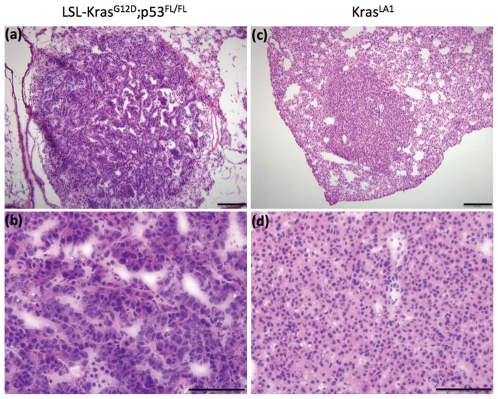
Hematoxylin and eosin staining showing characteristics of high-grade lung cancer in LSL-KrasG12D;p53FL/FL mice with pleomorphic nuclei (a,b) and low-grade KrasLA1 lung tumors in KrasLA1 mice with regular nuclei and minimal cytologic atypia (c,d).Images were acquired at 10× (a,c) and 40× magnification (c,d). Scale bars: 200 um in a and c; 100 um in b and d.